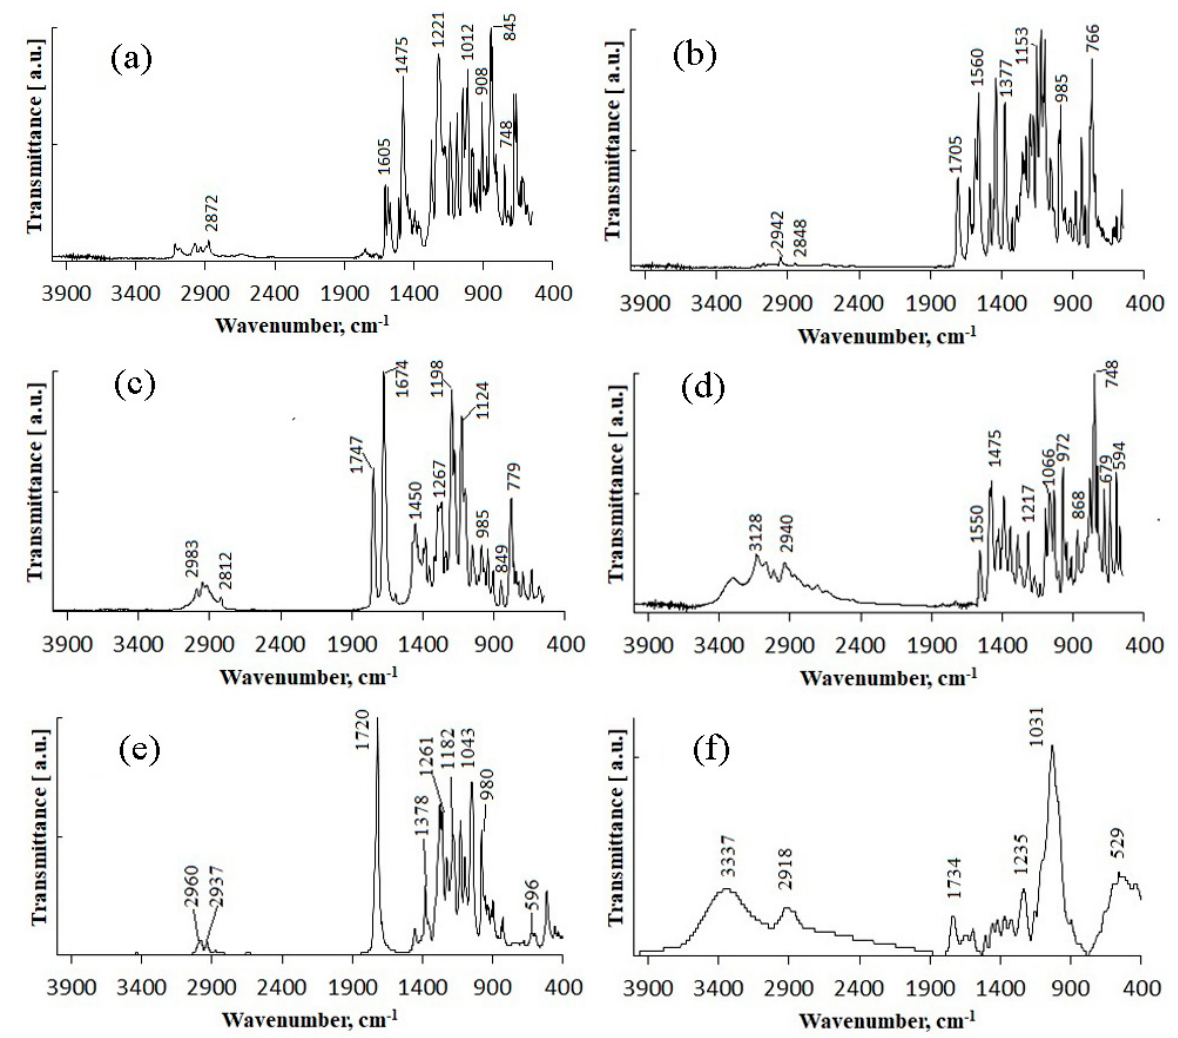
Figure 1. IR spectra of initial matrix materials and fungicides: ( a )—difenoconazole; ( b )—azoxystrobin; ( c )—mefenoxam; ( d )—prothioconazole; ( e )—P(3HB); ( f )—birch wood flour. Difenoconazole is an aromatic ester, dioxolane, triazole, cyclic ketal. The dioxolane